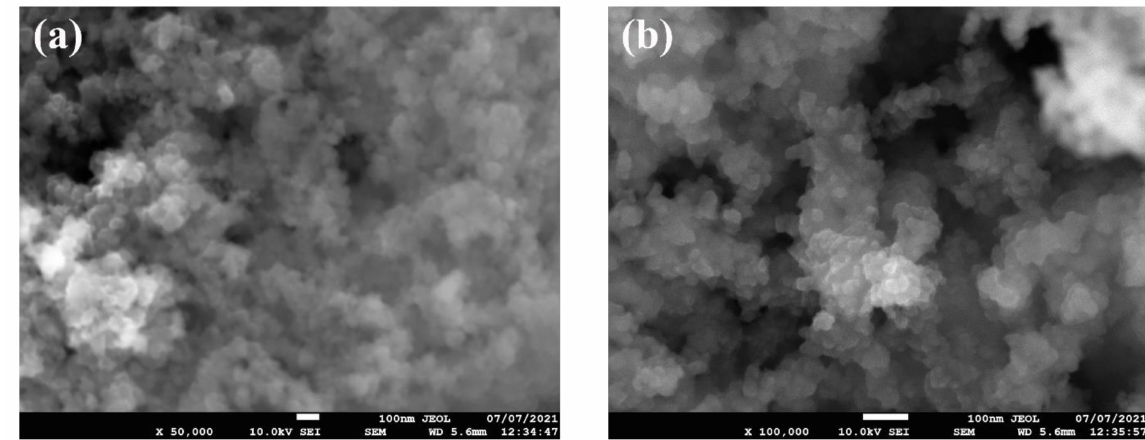
Figure 2. SEM micrographs of the as-received powder, where ( a ) shows the low-magnification image and ( b ) demonstrate the high-magnification image.